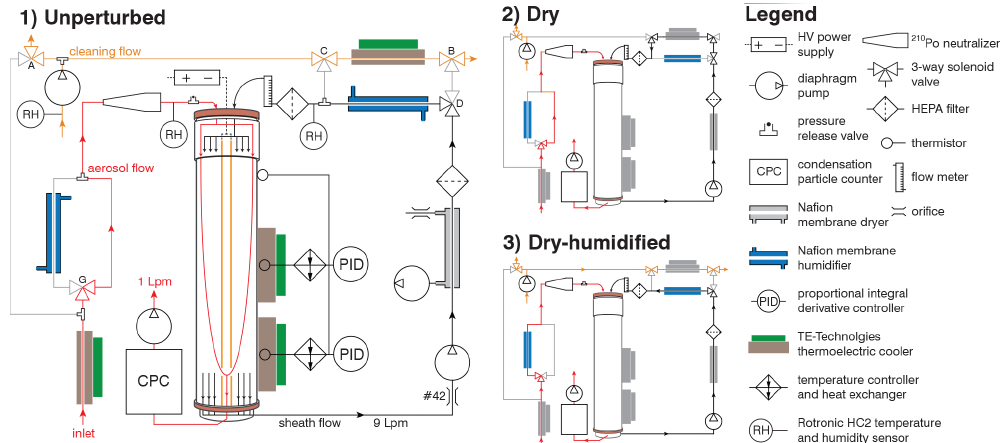
Figure 1. Instrument setup schematic. Red lines indicate the sample flow, black lines indicate the sheath flow, orange lines indicate the cleaning cycle flow, and grey lines indicate no flow. The column central to the figure is the differential mobility analyzer (DMA). Sheath and sample flows in the diagram are downward in the center and upward at the sides. The cleaning cycle is similar to the unperturbed cycle but with solenoid valve A toggled such that flushing air flows toward the actuated ball valve G and is split between the sample path to the CPC and the inlet, reversing the flow through the temperature-controlled